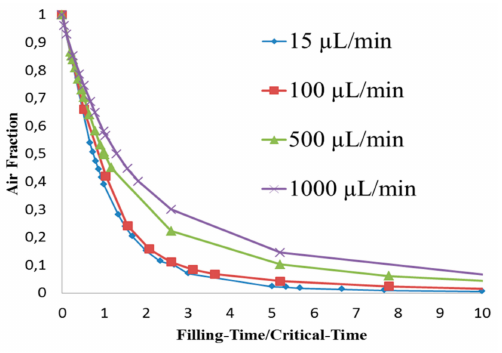
Figure 12. Overall air volume fraction in the chamber vs. Filling-Time/Critical-Time at liquid flow rates of 15, 100, 500, and 1000 µ L/min.